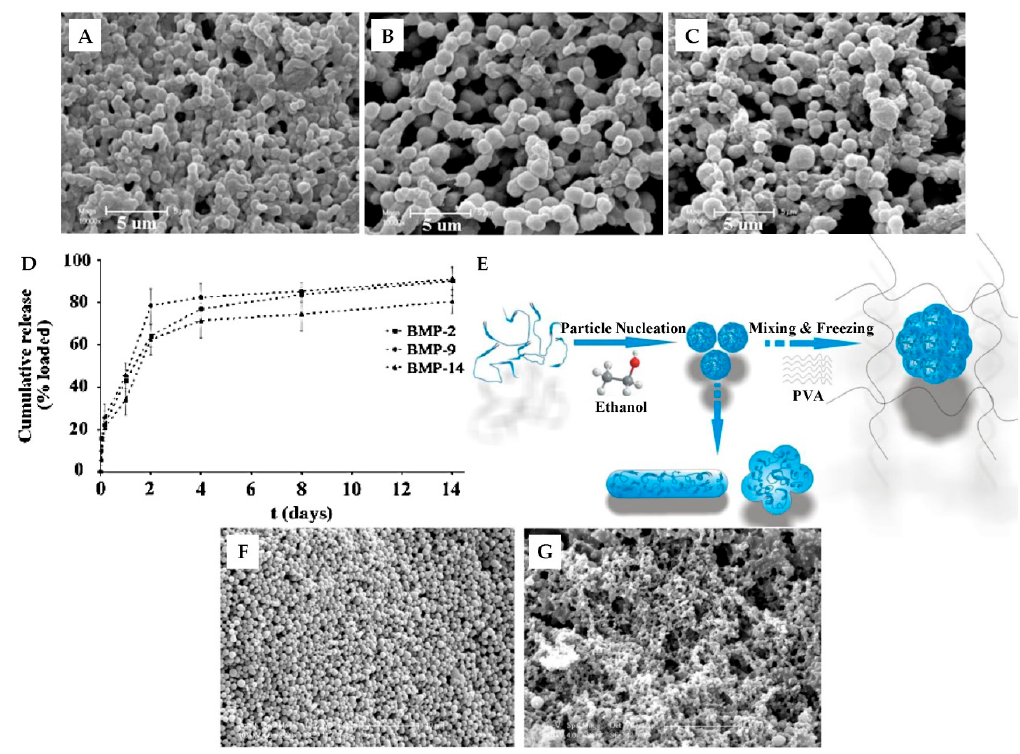
Figure 3. Scanning electron microscope (SEM) images ( A – C ) of SF microparticles fabricated with different SF: ethanol ratios, ( A ) 2:1, ( B ) 3:1 and ( C ) 4:1, scale bar: 5 μ m; ( D ) Release kinetics of bone morphogenetic protein (BMP)-2, BMP-9, and BMP-14 immobilized in SF particles, with 0.5 μ g of BMP per mg of SF. Reproduced from [38]; ( E ) Mechanism of SF particles’ regular formation ( F ) with addition of poly vinyl alcohol (PVA) and irregular formation ( G ) without addition of PVA, scale bar: 10 μ m. Reproduced from [39].